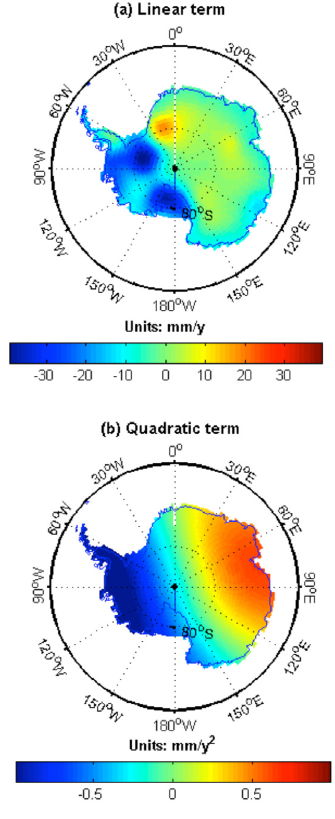
Figure 7. The linear and quadratic term of ice-sheet mass variations over Antarctica from 1993 to 2011 based on SLR